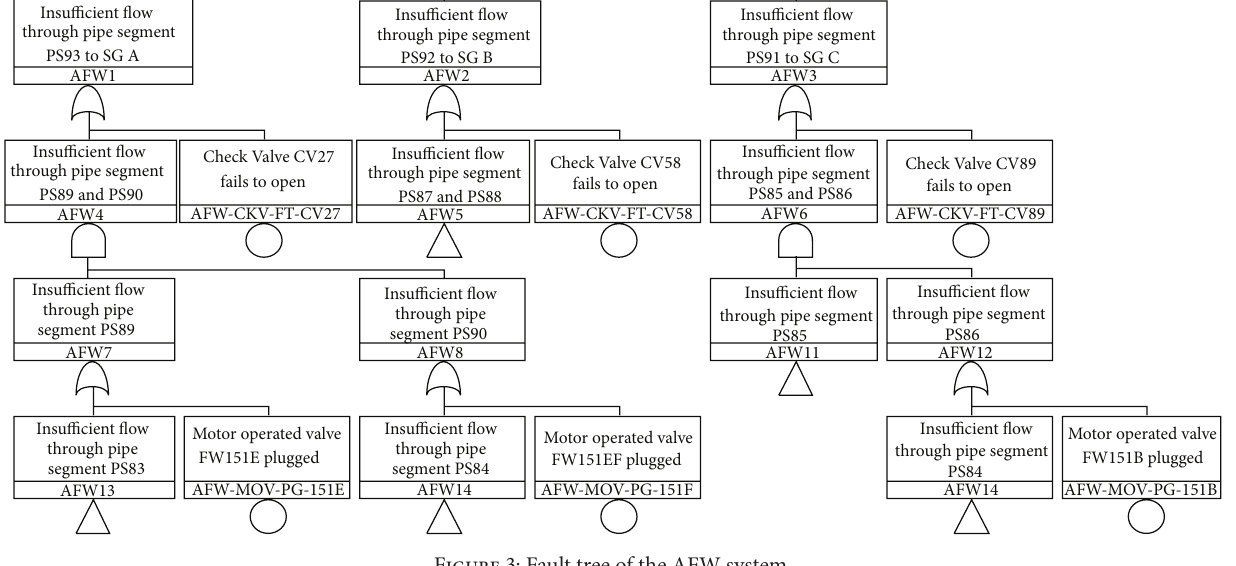
Figure 3: Fault tree of the AFW system.